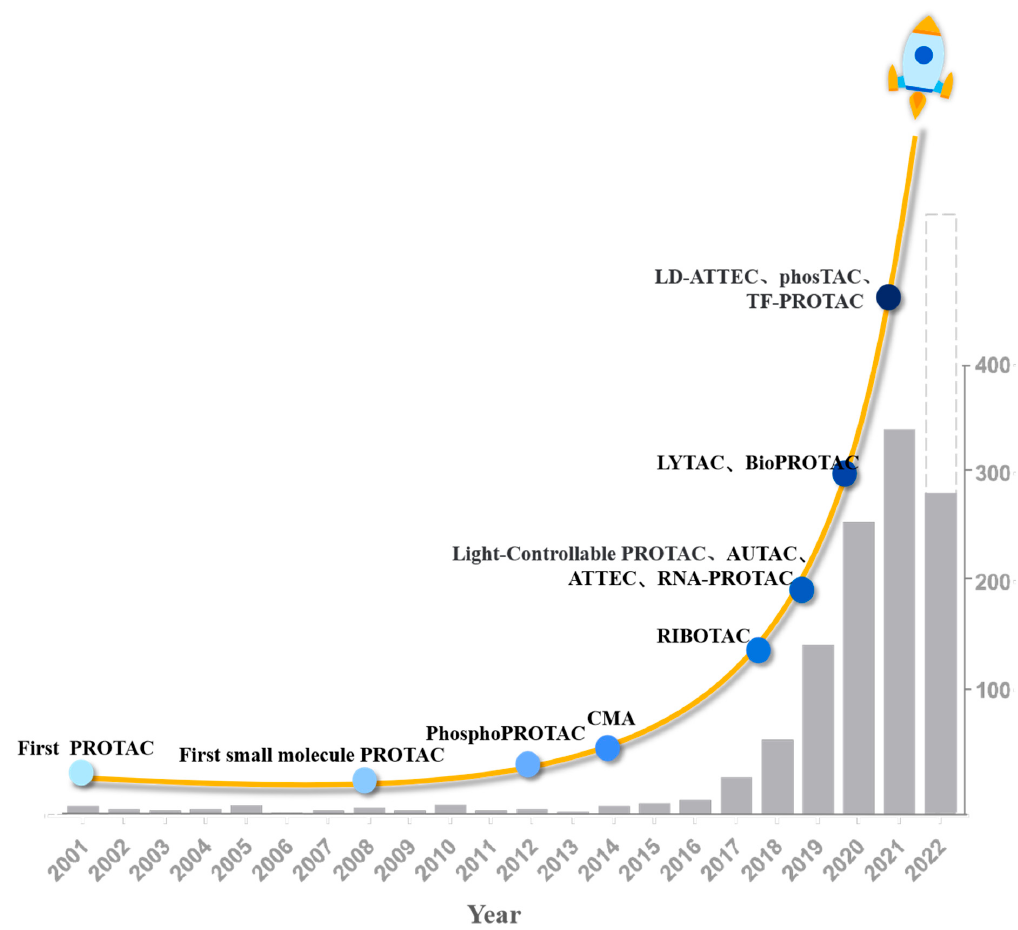
Figure 1. Timeline of milestones in protein degradation technologies (PDT) based on PROTAC development (2001–2022) and rough statistics on the number of PROTAC publications in PubMed (accessed in August 2022). The abscissa is the year and the ordinate is the quantity of publications of PROTACs. Since the first PROTAC was reported in 2001, both species and quantity of PDT have been greatly developed, especially in recent years. Among the more than 900 papers on PROTAC published at present, there are 786 papers in the three years from 2019 to 2021, accounting for about 80%, which is four times the number of papers published from 2001 to 2018. As of August 2022, 287 articles have been published, and the possible number of publications in this year was estimated by dotted lines.